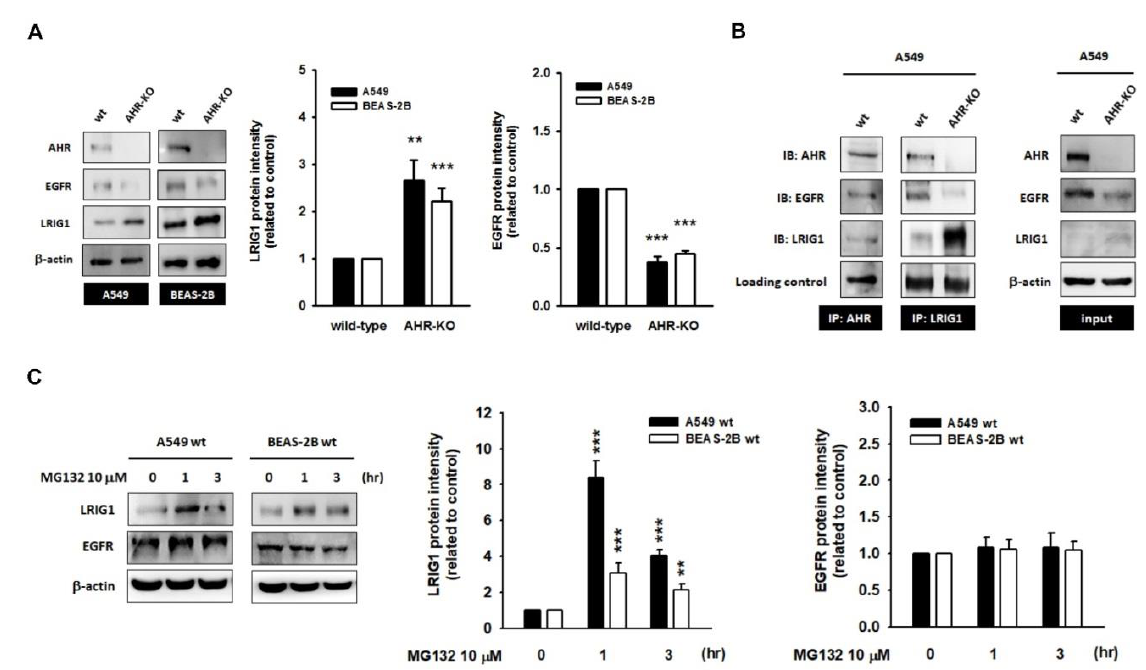
Figure 4. The expression of leucine-rich repeats and immunoglobulin-like domains 1 (LRIG1), the repressor of epidermal growth factor receptor (EGFR), was up-regulated in AHR-KO clones. ( A ) Representative images and quantitative data showed the up-regulation of LRIG1 protein level in AHR-KO clones. Contrarily, the EGFR is expressed in the opposite manner of LRIG1. ( B ) By using immunoprecipitation assay, the protein complex comprising of AHR, EGFR, and LRIG1 was demonstrated in A549 wt. However, in AHR-KO clones, less EGFR was associated with LRIG1. ( C ) A short-term incubation with MG132 (10 µ M; proteasome inhibitor) obviously boosted LRIG1 protein level in A549 and BEAS-2B, but without alternations on EGFR. These data suggest the interaction of LRIG1 to AHR might direct LRIG1 toward proteasome-dependent degradation. (** p < 0.01, *** p < 0.001, indicates statistically significant difference from the wild-type control).